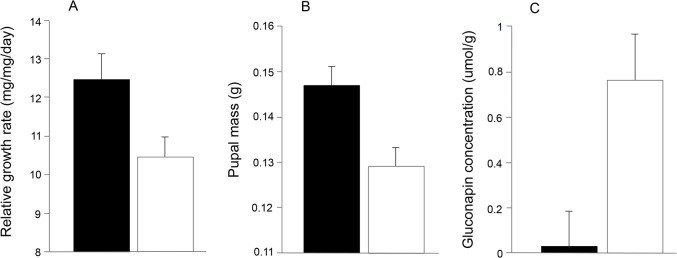
Differences in P. rapae performance and GS levels between high B:G (black bars) and low B:G (white bars) B. oleracea plants.A. Relative growth rates of larvae. B. Pupal mass (data show males and females). C. Concentration of the aliphatic GS gluconapin. Of the individual GS measured, only gluconapin levels were found to differ significantly between the bluest and least blue plants following Benjamini-Hochberg correction. Means ± SEM and results of statistical comparisons between high and B:G plants are presented in Table 2 (relative growth rate and pupal mass) and Table 3 (gluconapin concentration).